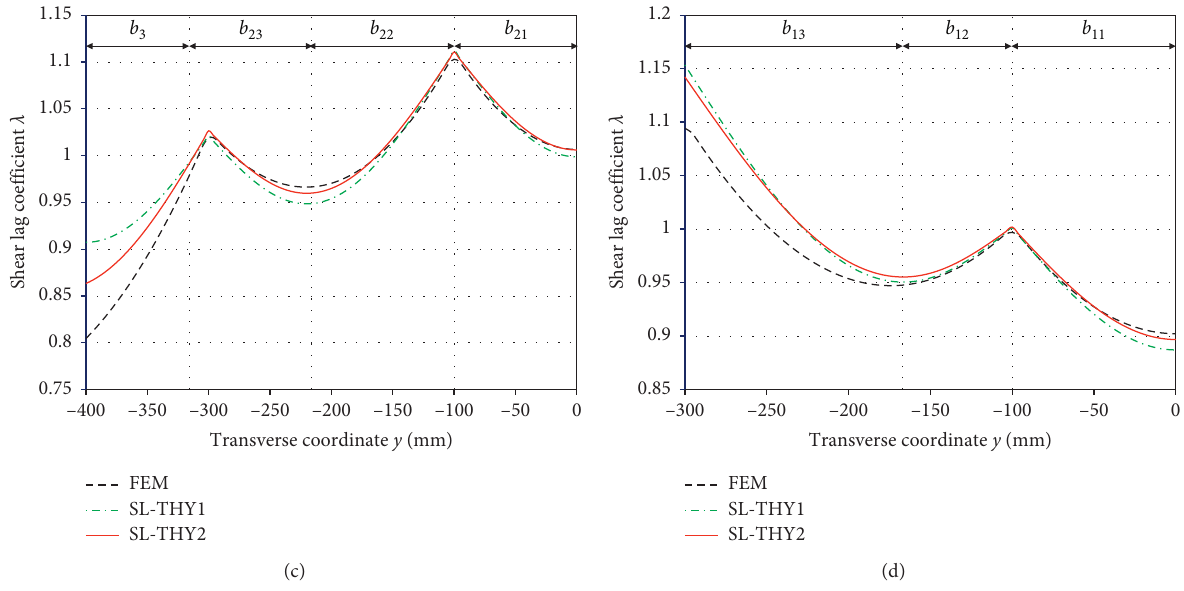
Figure 16: Shear lag coefficients of the fixed-end box girder. (a) Top flanges of midspan cross section ( x � 900mm). (b) Bottom flanges of midspan cross section ( x � 900mm). (c) Top flanges of 5/12-span cross section ( x � 750mm). (d) Bottom flanges of 5/12-span cross section ( x � 750mm).